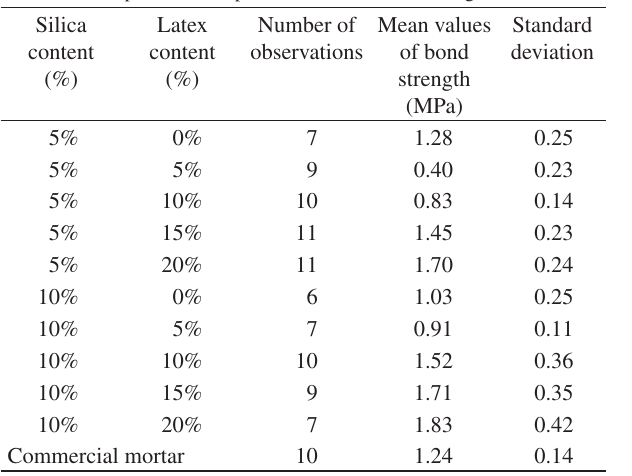
Table 4. Descriptive statistic performed for the bond strength values.